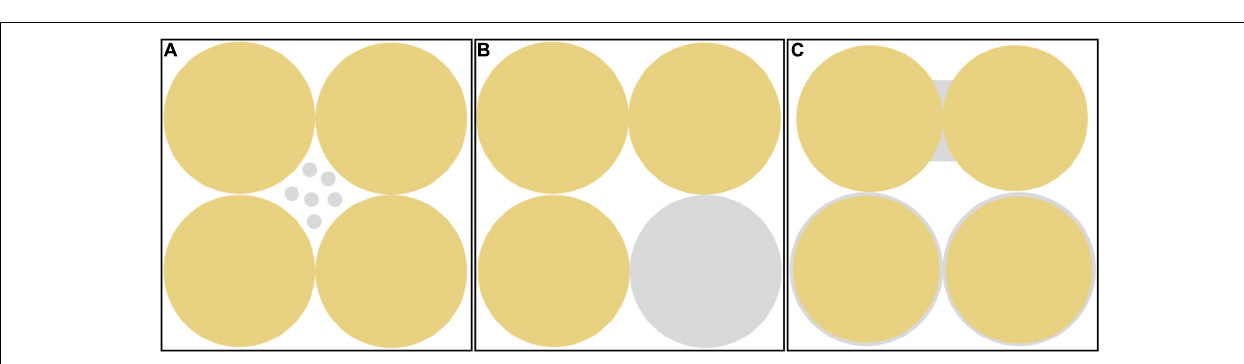
FIGURE 2 | Different distributions of hydrate in the sediment. (A) Pore-filling hydrate; (B) load-bearing hydrate; (C) contact-cementing and envelope-cementing hydrate.